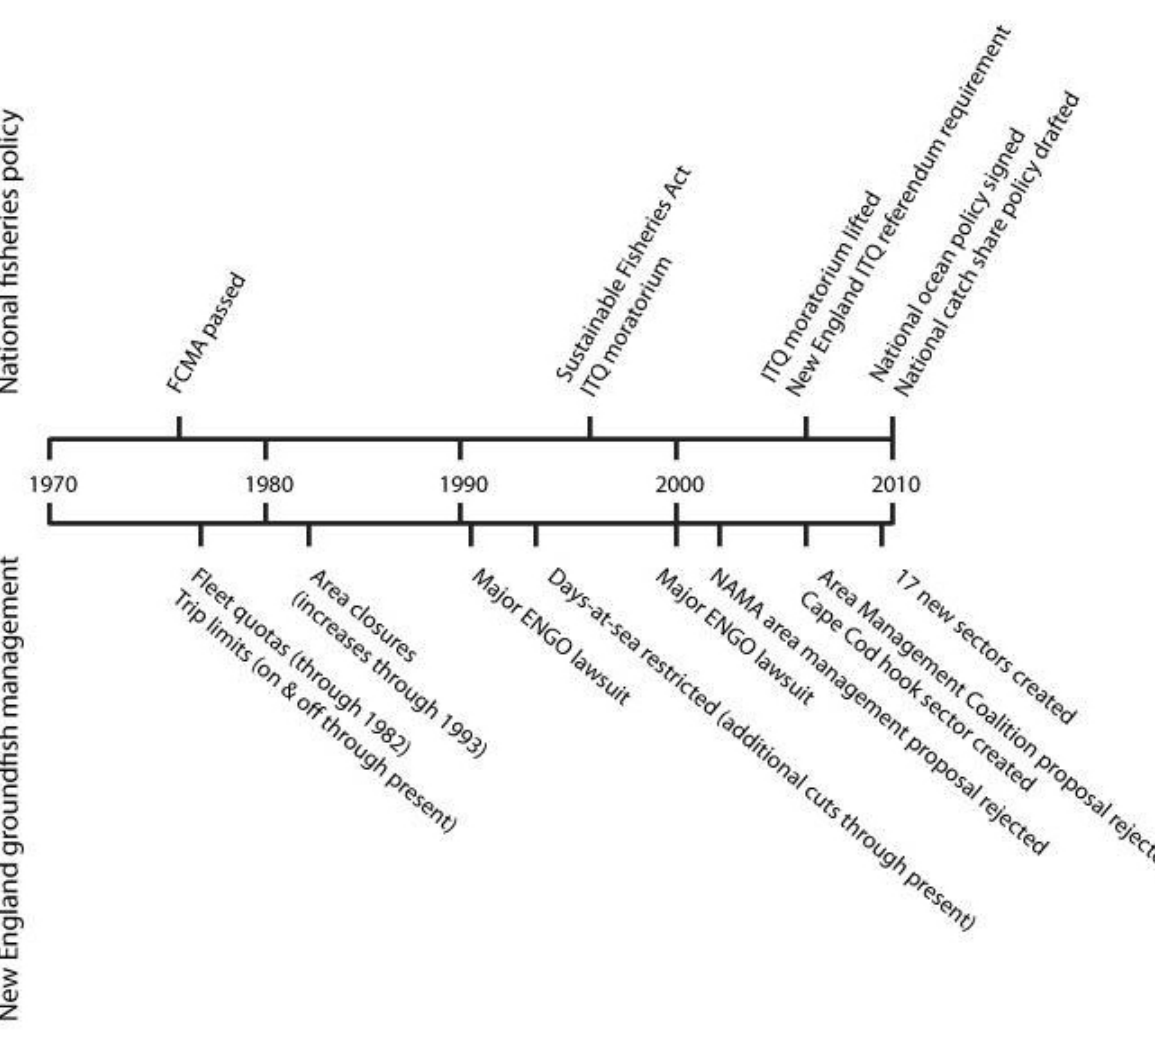
Fig. 1. Timeline of key national policy and regional management events in the New England groundfishery since